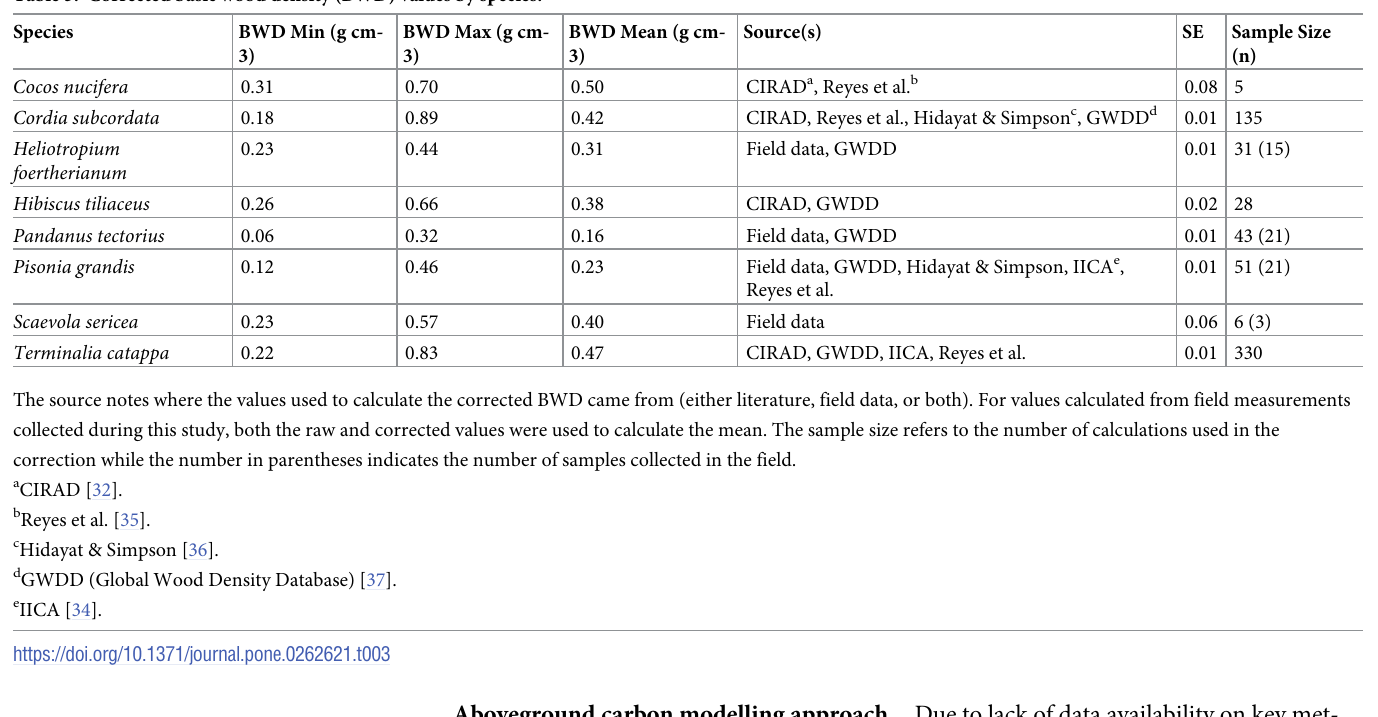
Table 3. Corrected basic wood density (BWD) values by